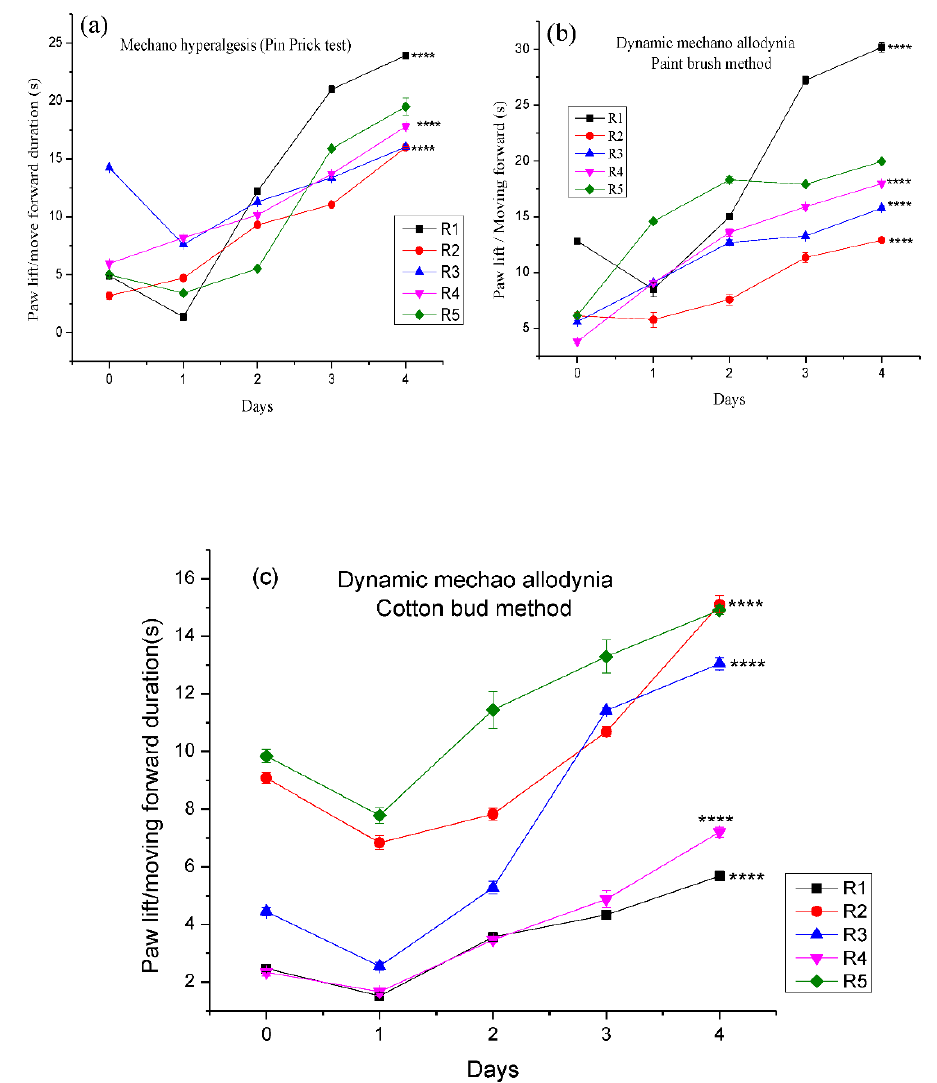
Figure 10. Mechano-hyperalgesia and mechano-allodynia: ( a ) pin prick test, ( b ) paint brush method, and ( c ) cotton bud method. Where, **** represents very much significant.